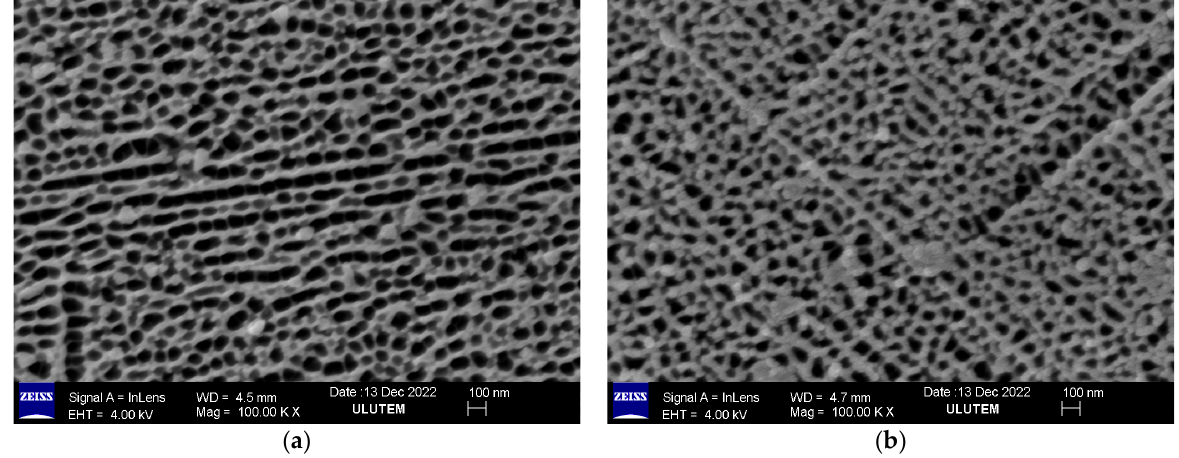
Figure 2. SEM images of ( a ) 3 nm and ( b ) 20 nm Pt coated on the AAO substrates.